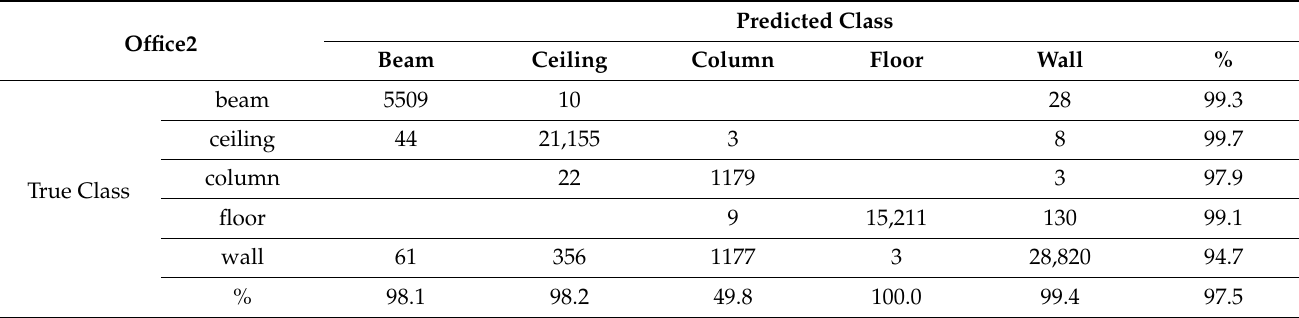
Table 2. Office_2 confusion matrix. The overall accuracy is